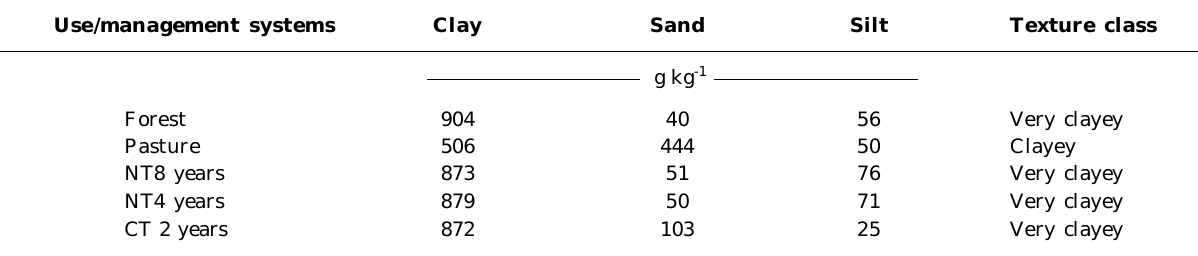
Table (cid:172) 1. (cid:172) Vegetation, location, soil classification, altitude (m), climate and parent material of the pedon sampling